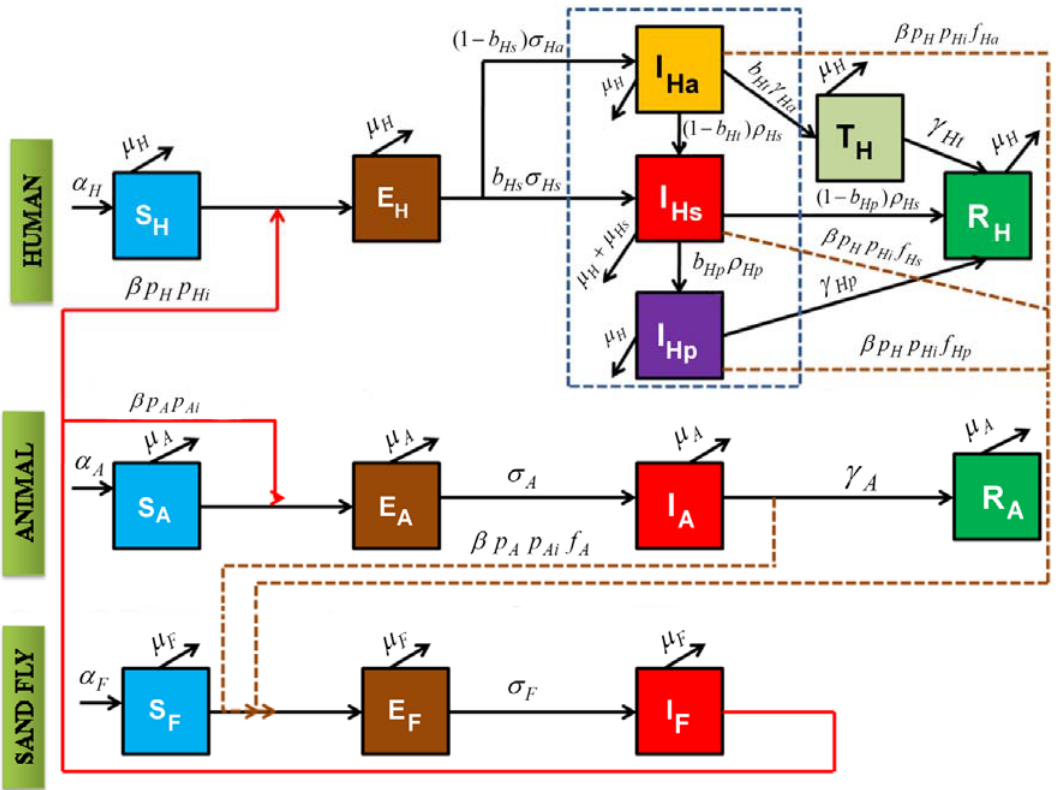
Figure 1. Schematic representing the flow of infection between different population groups considered in the model. Each directed arrow represents the flow of infection. The corresponding parameters are given above each arrow. Arrows leaving a compartment but not connected to any other compartment represent the mortality (death) of individuals in that compartment. The arrows directed towards the susceptible compartments and not connected with any other compartment represent the birth rates of that